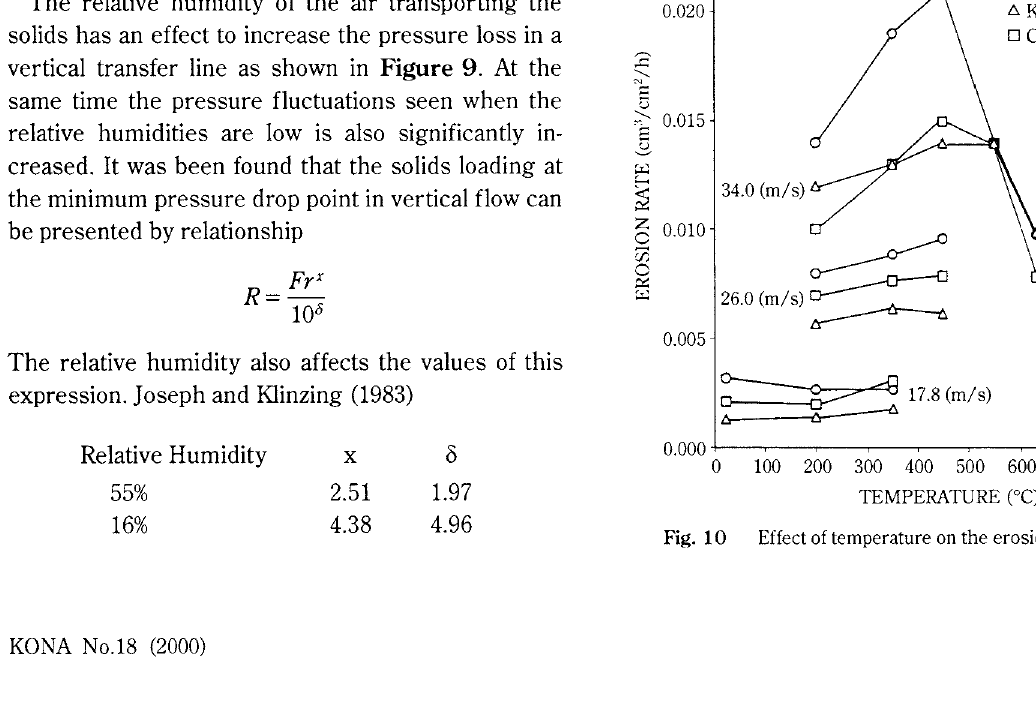
Effect of temperature on the erosion rate by